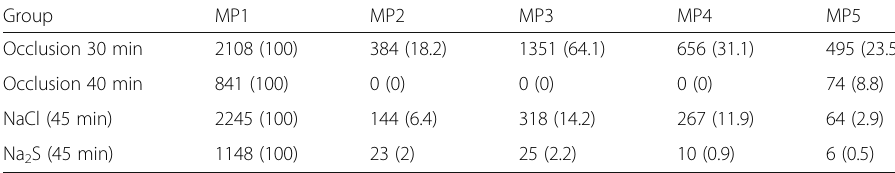
Table 2 Motor evoked potentials (MEPs) during the